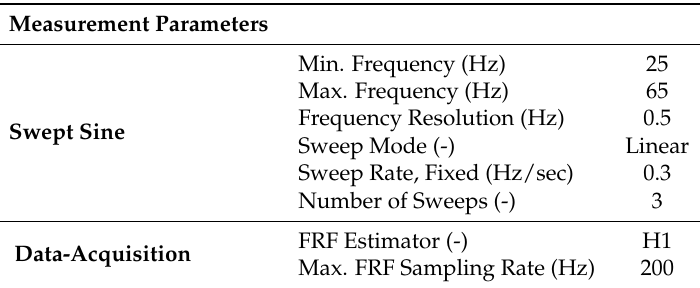
Table 2. Overview of the measurement